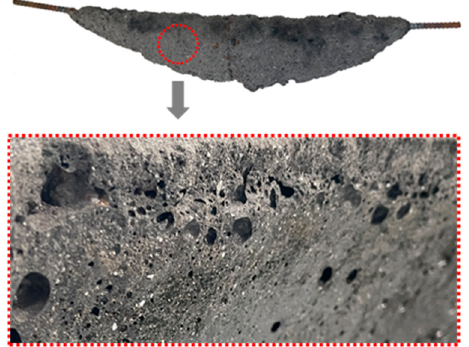
Figure 8. Vitrified heavy metals. Table 3. Residual contaminants in treated soil with remediation time.